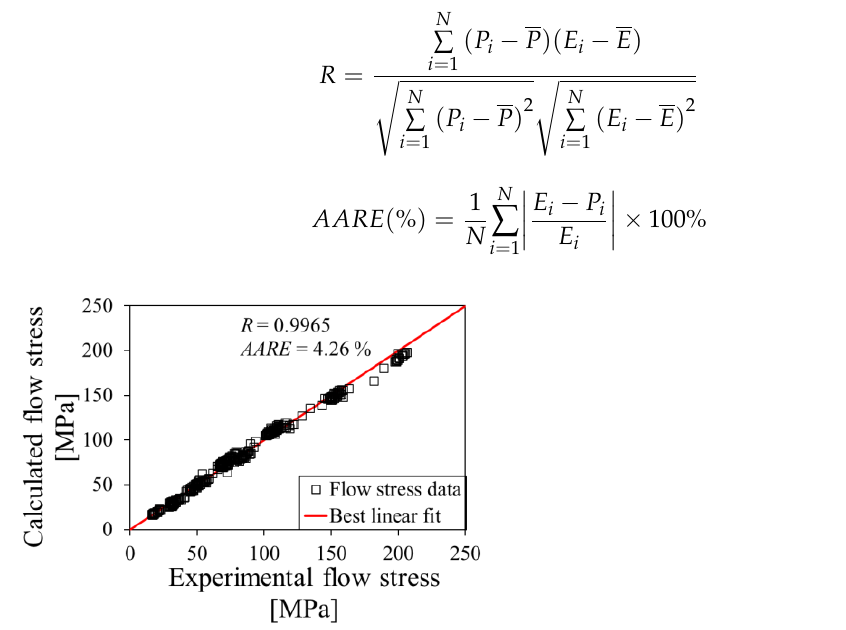
Figure 8. Correlation between experimental and predicted flow stress by the constitutive equations.